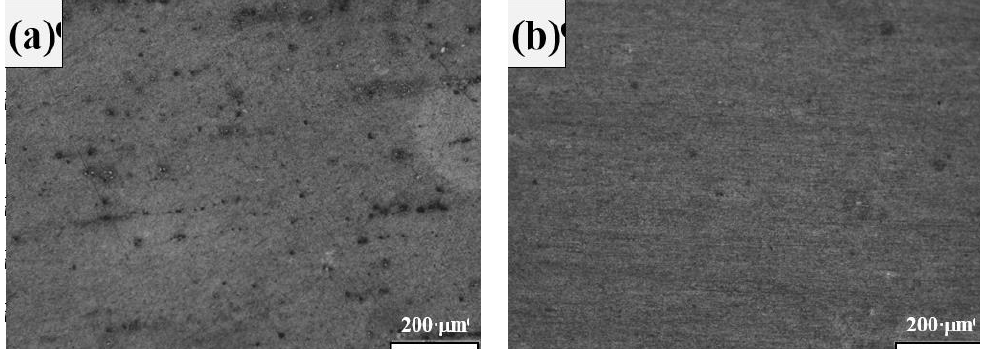
Figure 5. SEM images obtained after immersion in 0.9 M NaOH (pH = 13.9) + 0.2% Cl − solutions. ( a ) Standard rebar and ( b ) DP steel.